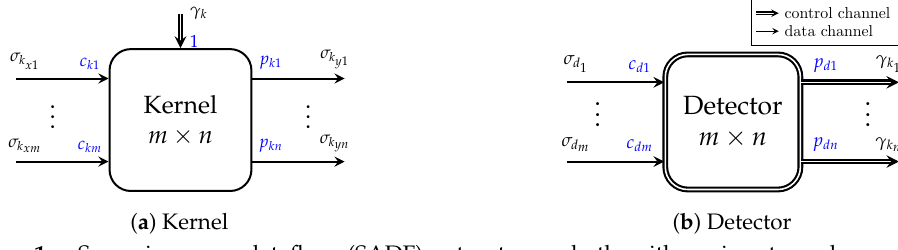
Figure 1. Scenario-aware dataflow (SADF) actor types, both with m inputs and n outputs, from Reference